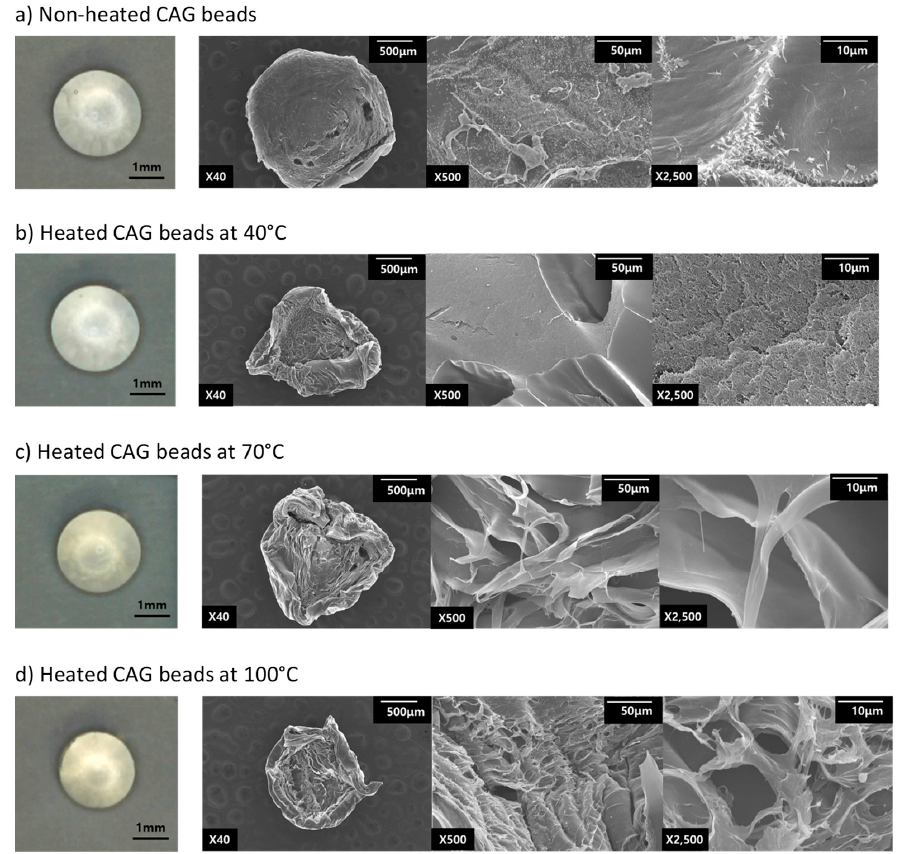
Figure 3. Digital microscope (left), and SEM (right) photographs of CAG beads frozen in liquid nitrogen and freeze-dried: ( a ) before heat treatment CAG bead; ( b ) CAG beads were heated at 40 ◦ C; ( c ) CAG beads were heated at 70 ◦ C; ( d ) CAG beads were heated at 100 ◦ C. Magnification of the images are 40 × , 500 × , and 2500 ×. Table 6. Density (g/cm 3 ) of CAG beads.